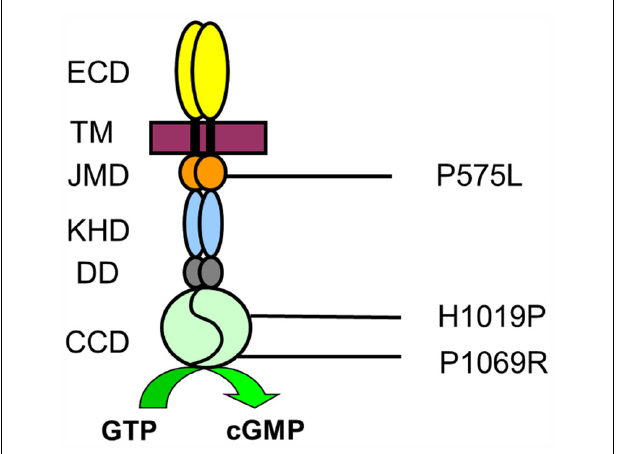
FIGURE 1 |Amino acid positions of mutations in ROS-GC1. Topology of ROS-GC1 domains is indicated as extracellular domain (ECD) corresponding to the intradiscal region when cyclases are expressed in rod outer segments, transmembrane domain (TM), JMD, KHD, dimerization domain, and cyclase catalytic domain (CCD). Numbers correspond to the unprocessed human